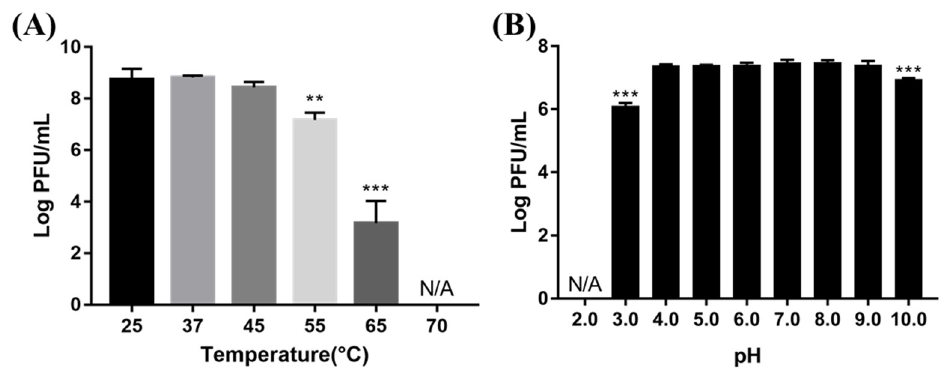
Figure 5. Effect of various temperatures ( A ) and pH conditions ( B ) on phage viability. All experiments were independently performed in triplicate, and the results are presented as mean ± SD. Asterisks indicate statistical significance (** p < 0.01, *** p <0.001). N/A: not